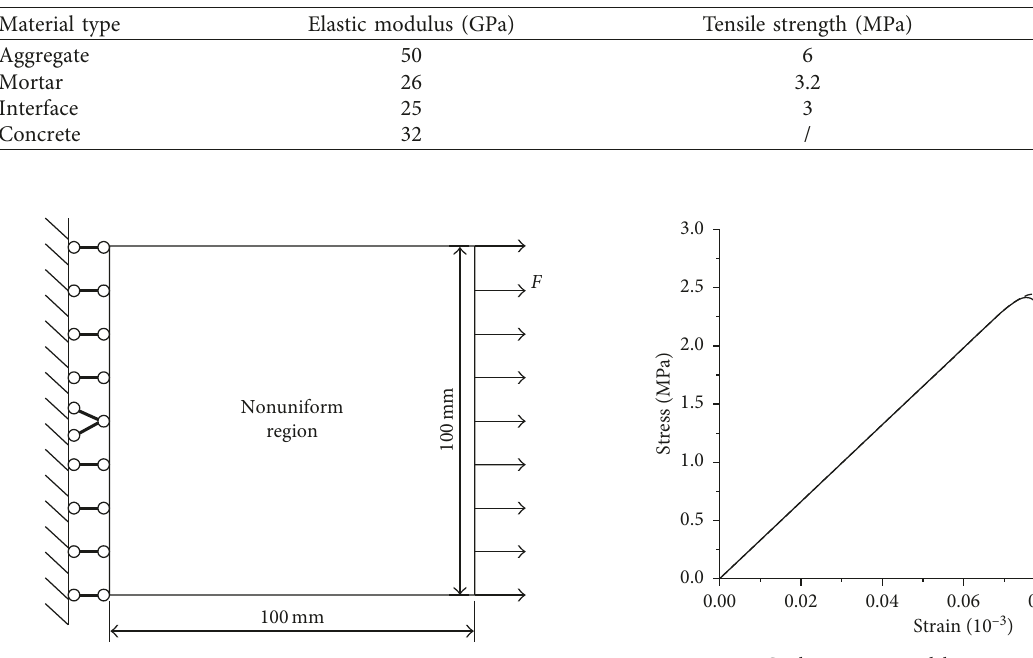
Figure 8: Double-fold line damage constitutive relation. Table 1: Concrete phase material mechanical parameters.